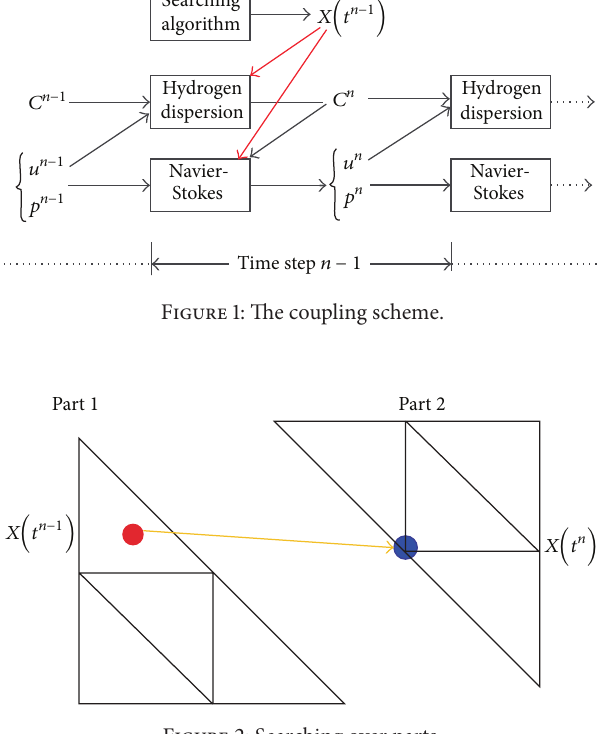
Table 1: The material